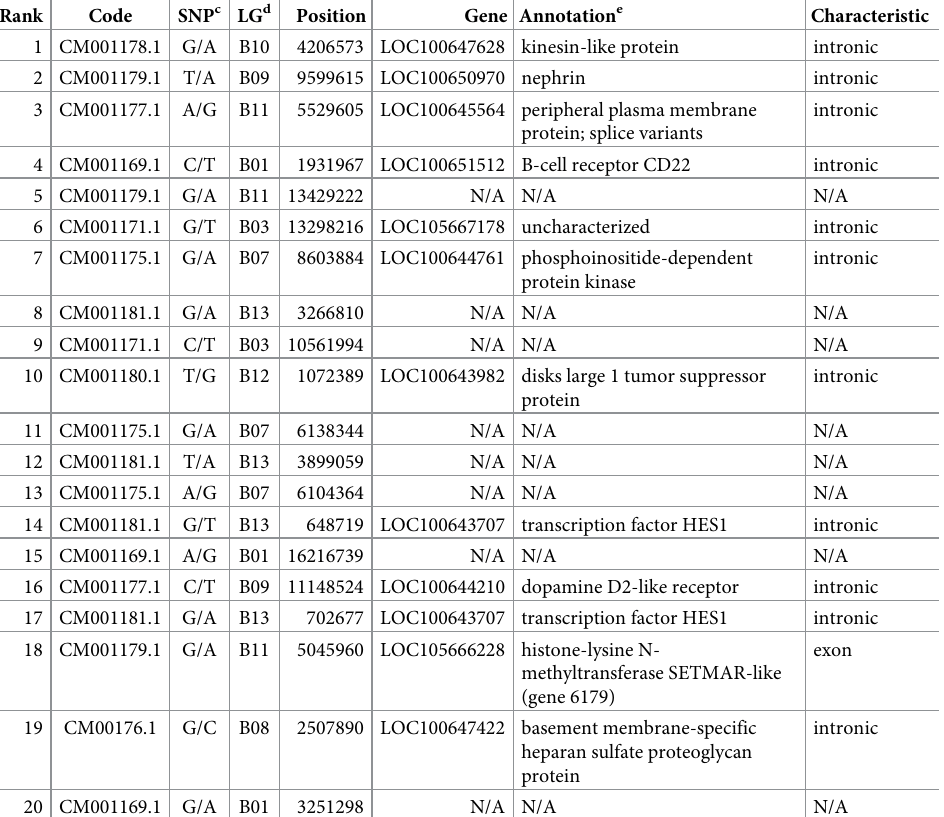
Table 2. GWAS from low-coverage study (20 x 20